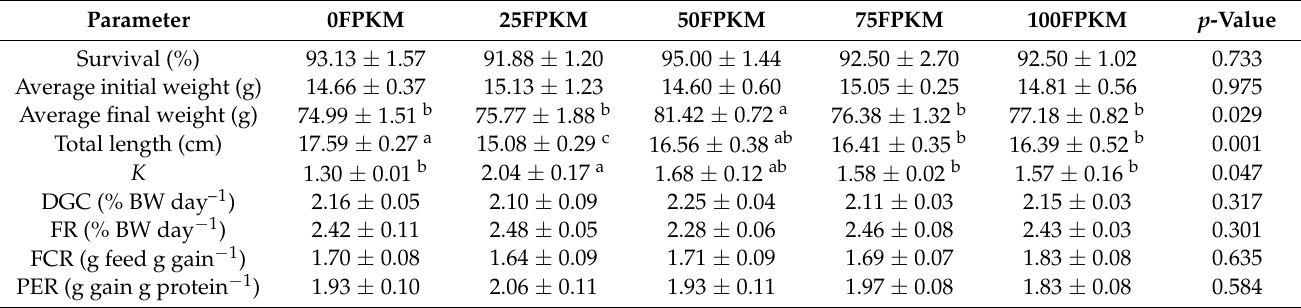
Table 3. Survival, growth performance and feed utilization of sex-reversed red tilapia fed with experimental diets containing varying levels of FPKM for 12 weeks.